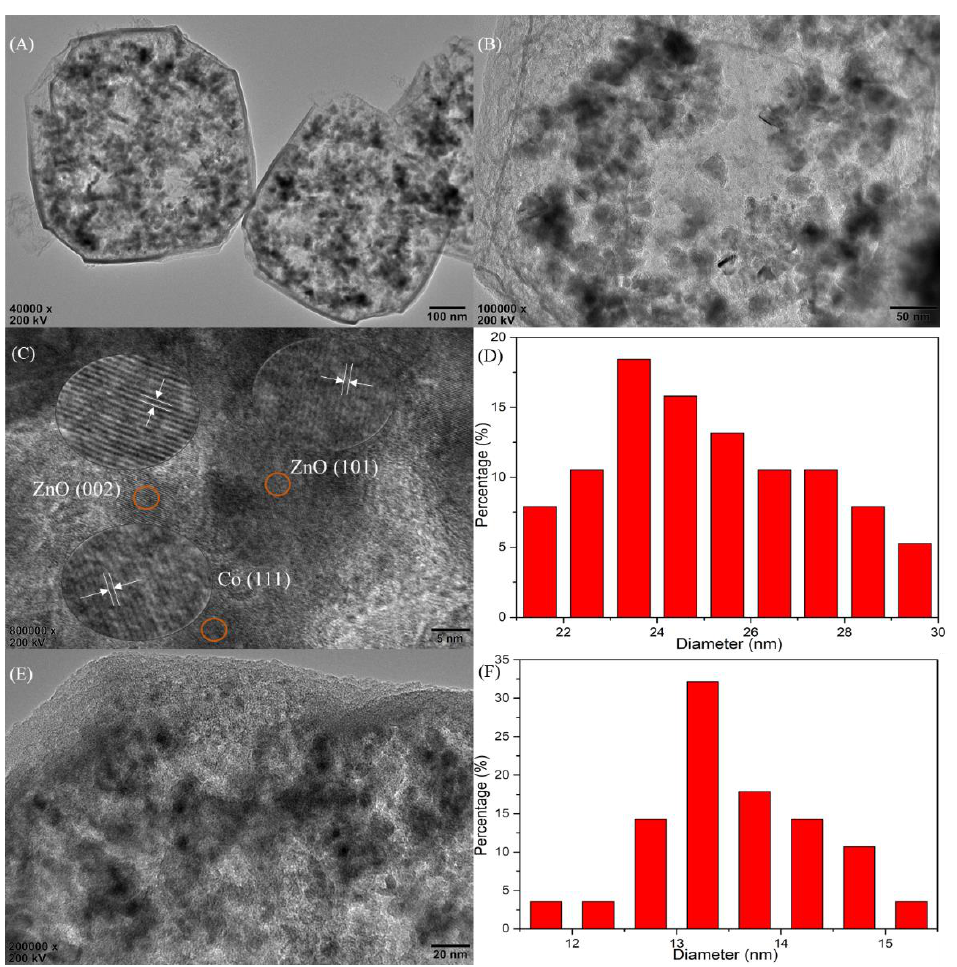
Figure 4. ( A – C ) HRTEM images of ZnCo/NC-600; ( D ) particle size distributions of ZnCo/NC-600; ( E ) HRTEM images of ZnO/NC-600; ( F ) particle size distributions of ZnO/NC-600.